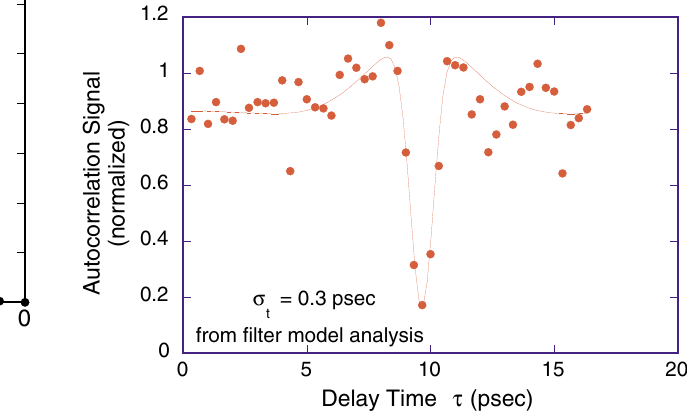
FIG. 24. (Color) Autocorrelation data for the optimally com- pressed bunch at PLEIADES.